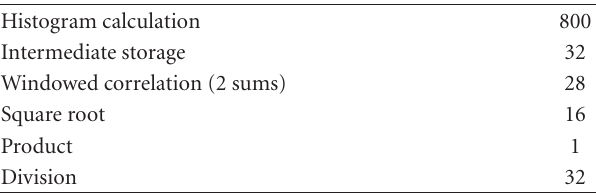
Table 3: Summary of number of clock cycles taken per operation.